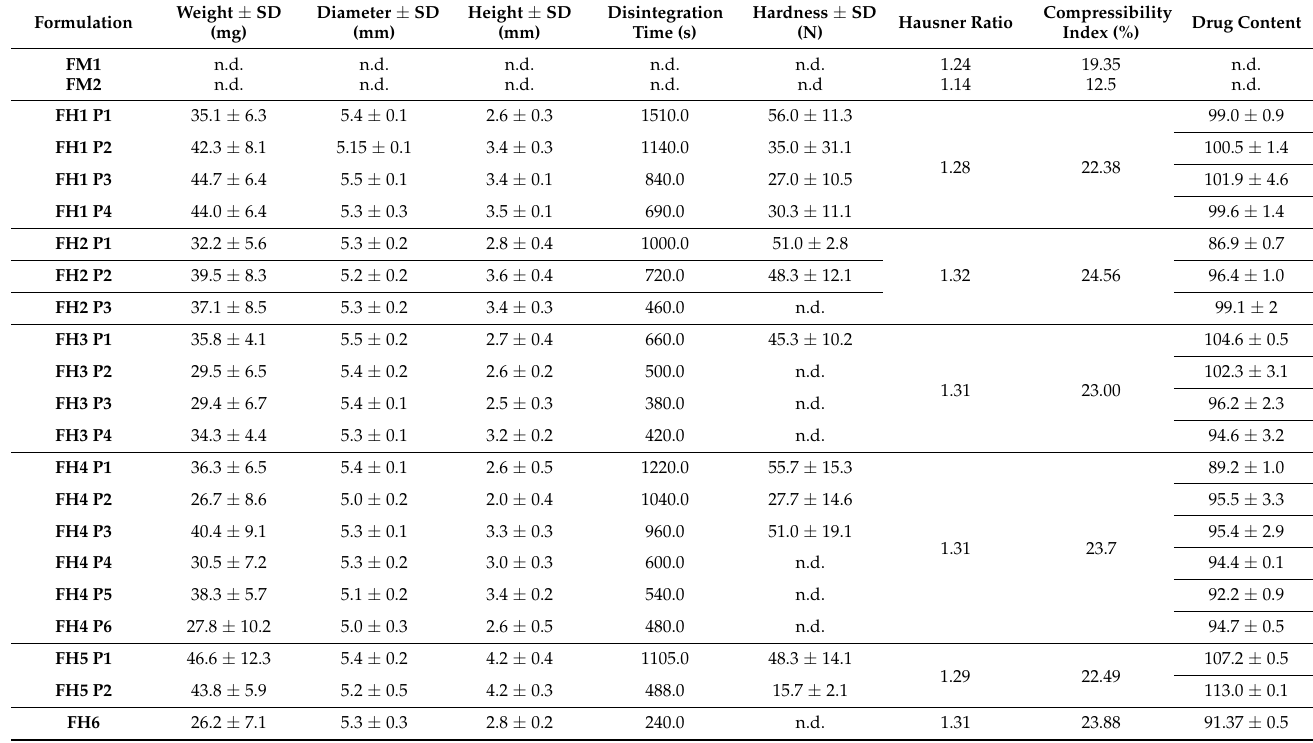
Table 3. Physical and mechanical properties of irbesartan